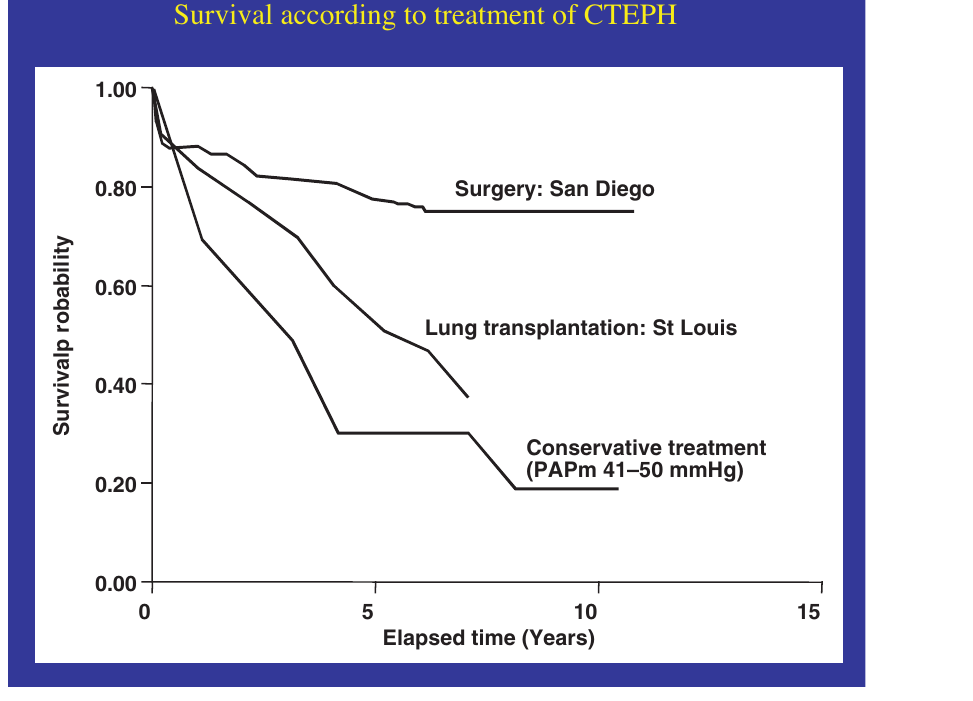
Survival with chronic thromboembolic dis- ease. Historical sur- vival of patients with severe pulmonary hypertension is com- pared with survivals recently published after transplantation or thrombo-embolec-